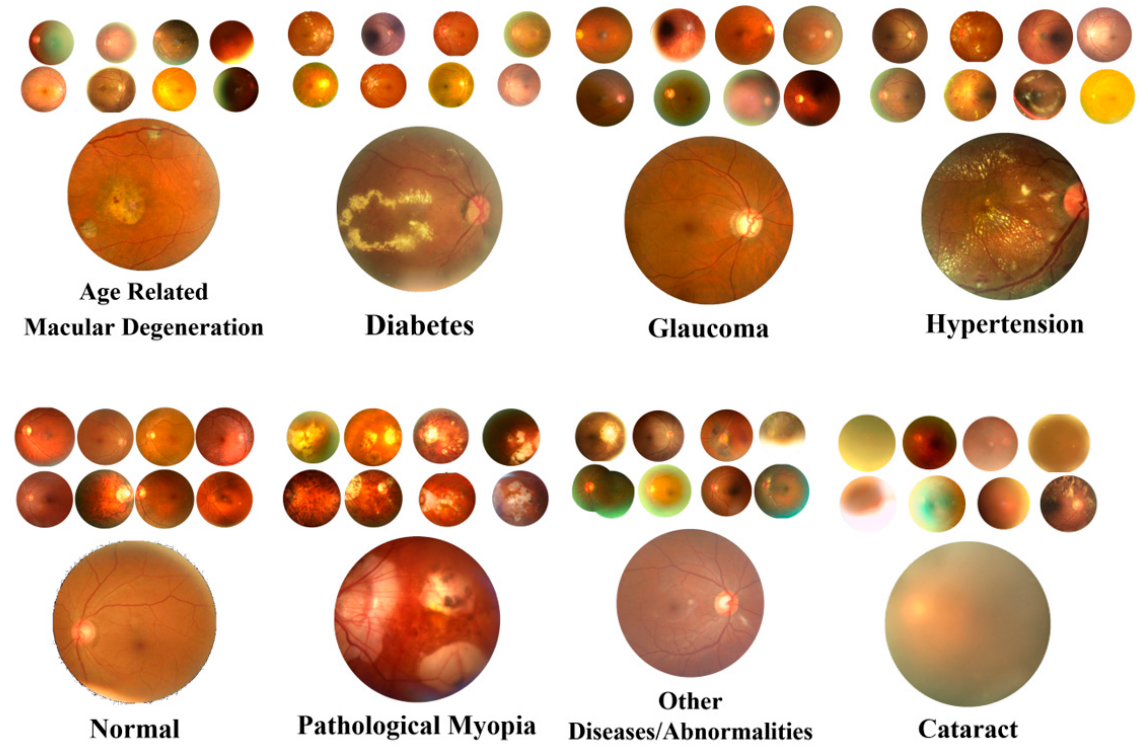
Figure 3. Some samples for each class in the dataset.